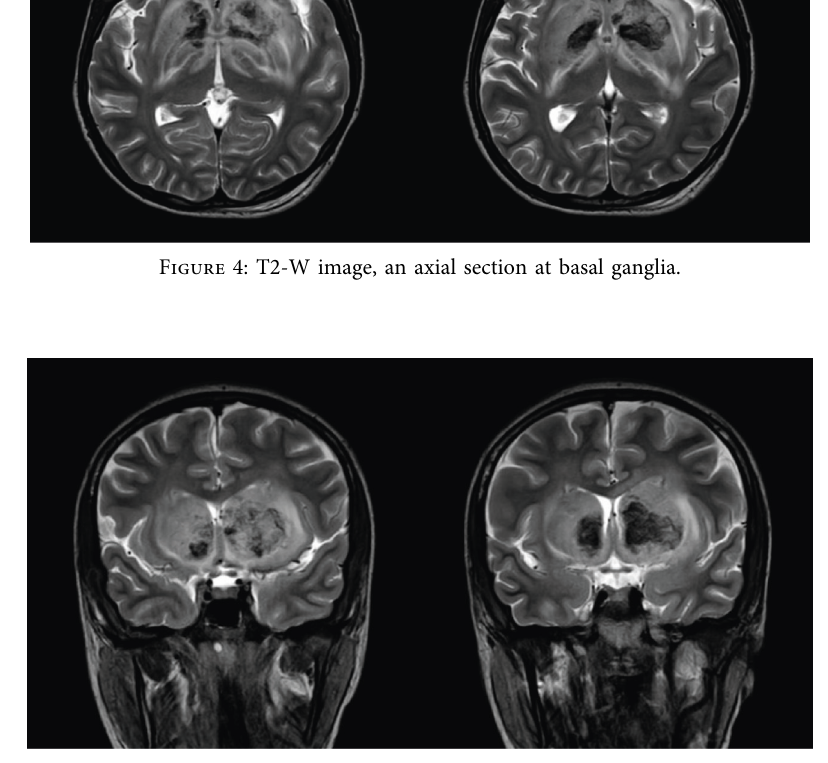
Figure 5: T2-W image, a coronal section at basal